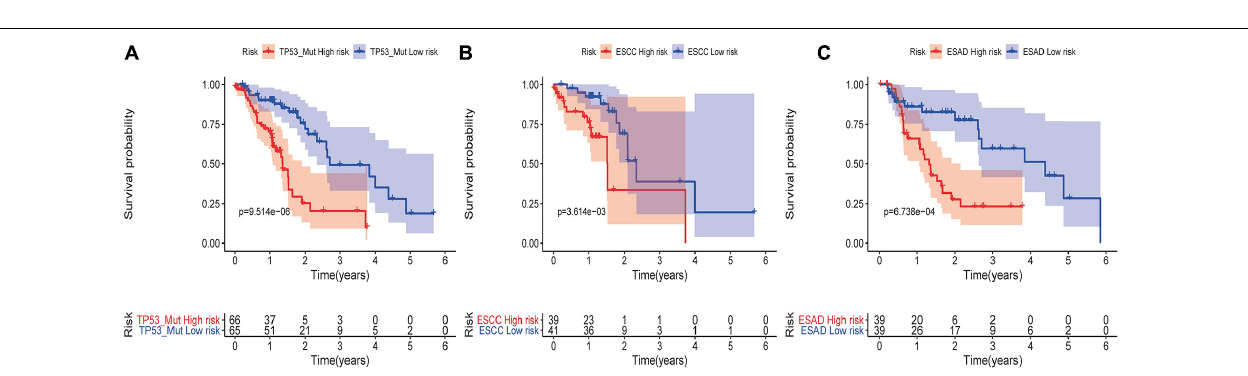
FIGURE 5 | The prognostic values of the signature. (A) Kaplan-Meier survival curves of the relative overall survival of high- and low-risk patients. (B) ROC curve analysis of the prognostic signature. (C) Heatmap of three-gene expression profiles in the high- and low-risk groups. (D) The distribution of the three gene-based risk scores. (E) Vital statuses of patients in the high- and low-risk groups.